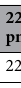
Table 3. Number of mislabeled images that showed abnormalities among the 100 most valuable and 100 least valuable chest X-ray images. All high value images that were mislabeled as pneumonia showed abnormalities to certain degrees. In contrast, only 2 out of 13 low value images that were mislabeled as pneumonia showed abnormalities. Moreover, 50 out of 52 low value images that were mislabeled as no pneumonia showed 2 abnormal opacity. a p value computed using χ